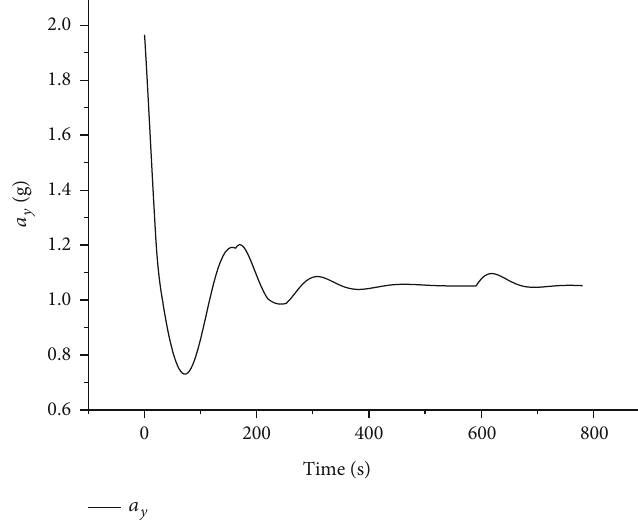
Figure 9: Normal acceleration with constant